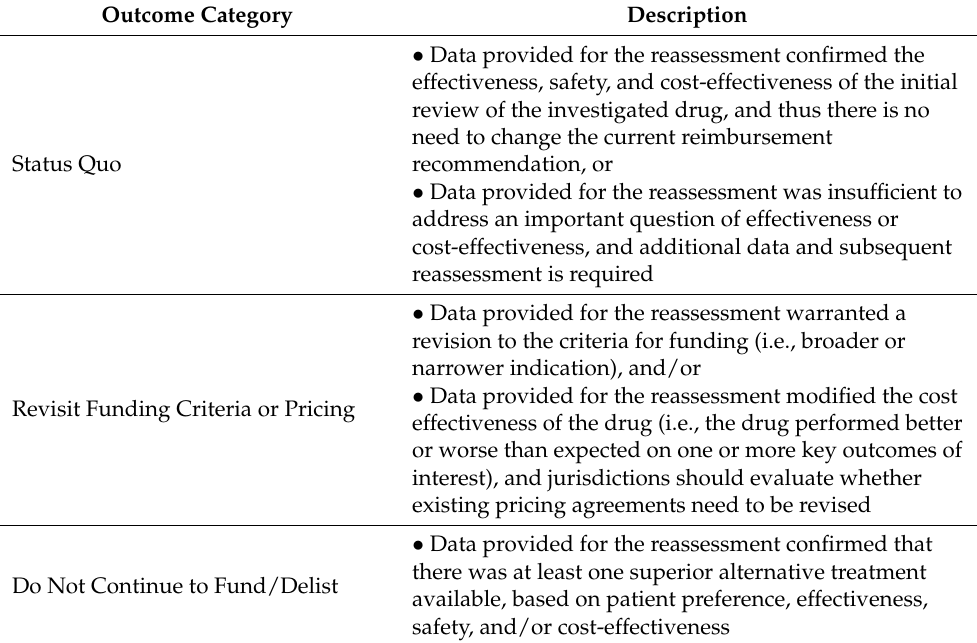
Table 3. Description of Reassessment Outcome